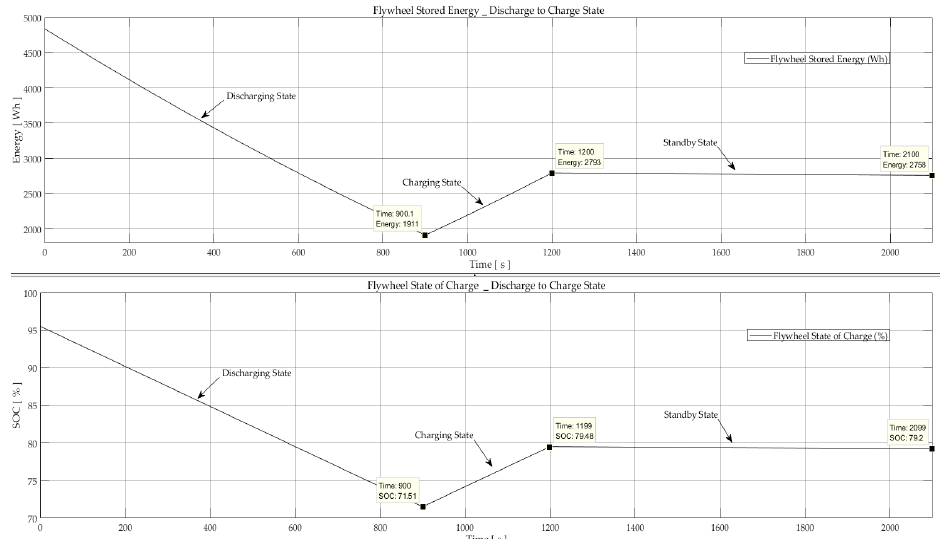
Figure 13. FESS in discharging mode: Flywheel stored energy (top); Flywheel SOC (bottom).